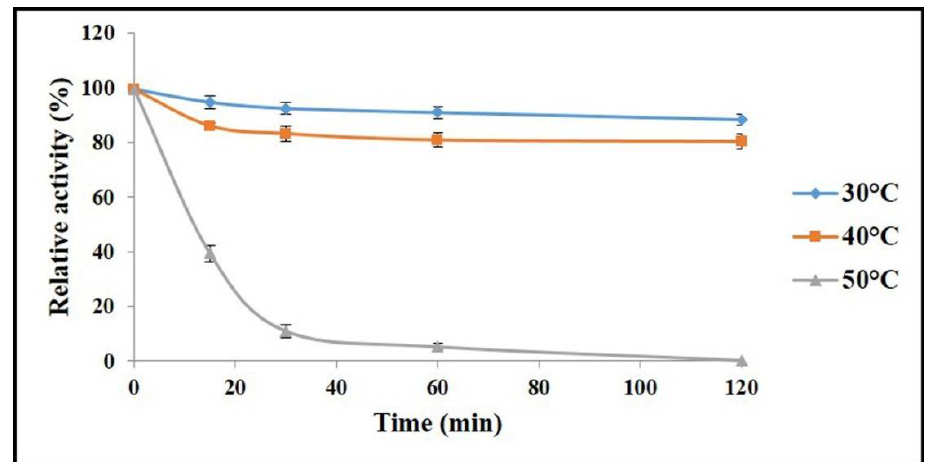
Figure 4. Thermal stability of AnEPG.